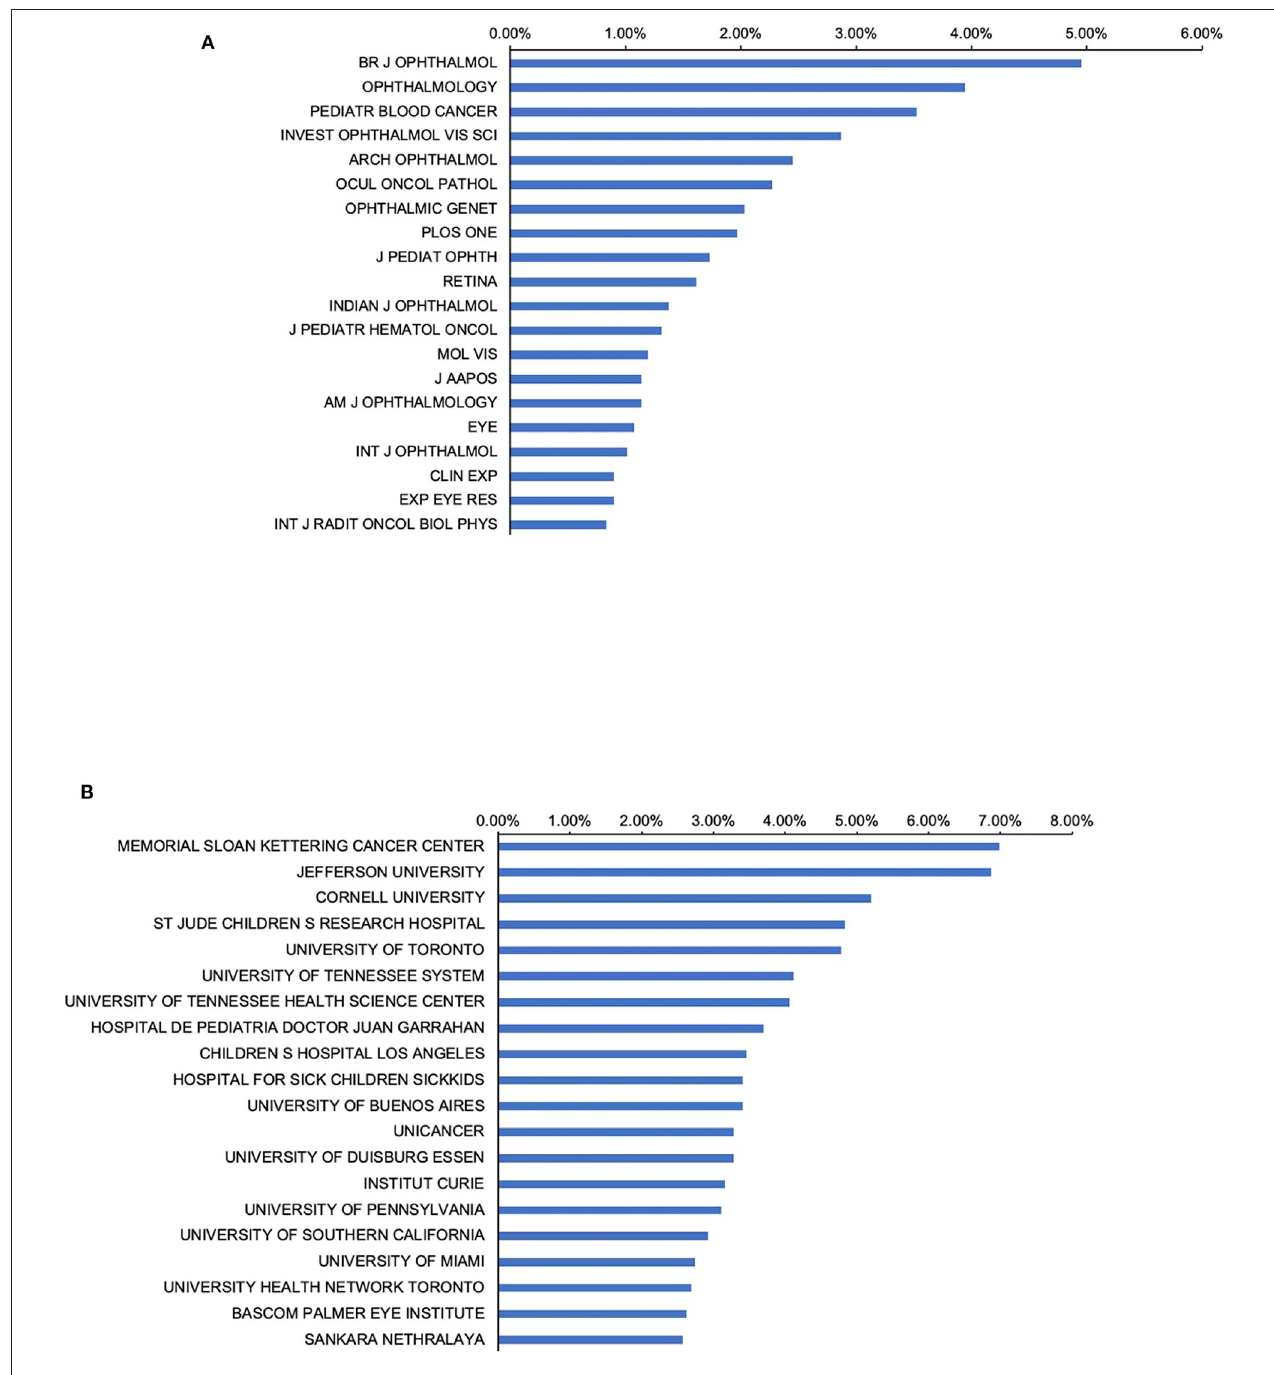
FIGURE 4 | Distribution of journals and institutions focusing on retinoblastoma. (A) Distribution of the top 20 journals publishing research in the field; (B) Distribution of the top 20 institutes publishing research in the field.